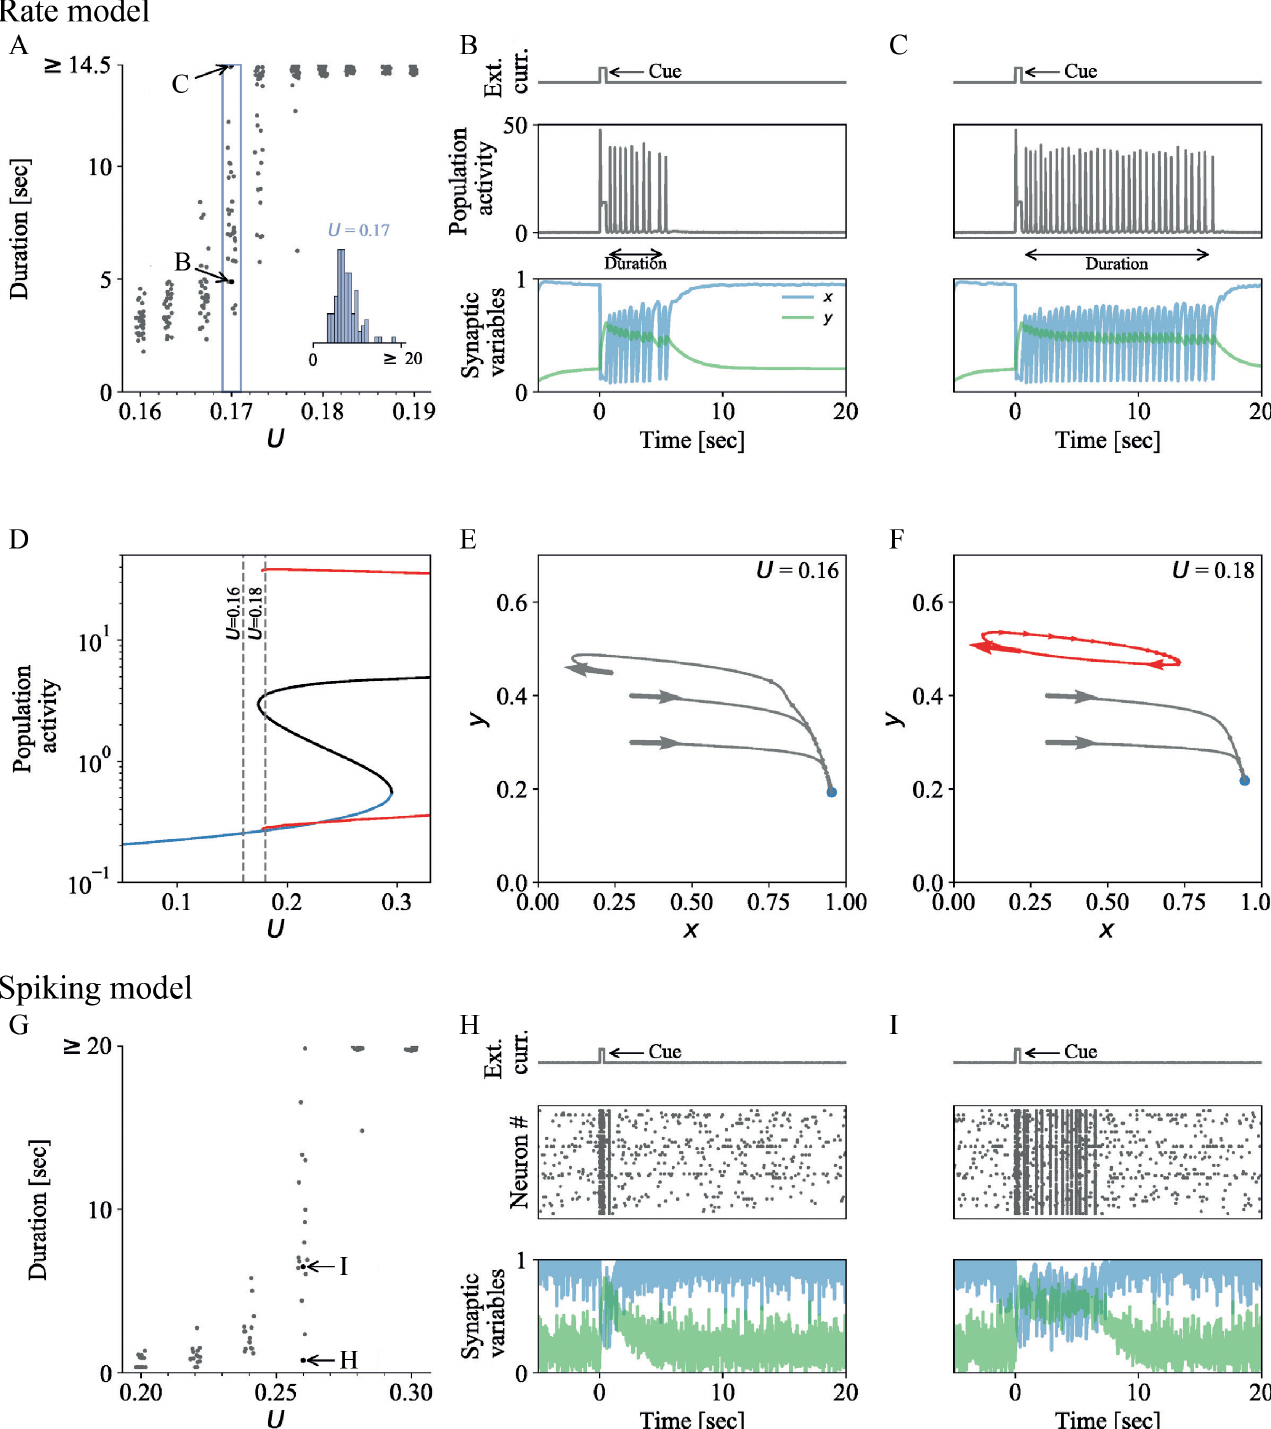
Fig 4. Transient WM activity is modulated by synaptic dynamics in STP rate and spiking networks without LPA signaling ( Δ U = 0). A-F Analysis of the STP rate model (see Models and methods, Table C in S1 Text; network parameters as in Table D in S1 Text except otherwise specified). A WM durations for 30 simulations at 10 values of U . As the phase transition is crossed, the range of durations of transient population activity upon cue stimulation increases b continuously (a hysteresis effect emerges if the cue is weak, see Fig I in S1 Text). Inset: Distribution of transient WM durations of 100 simulations at U b = 0.17. B-C Two simulations at U = 0.17. The external input current with the cue stimulus is shown in the top panel, population activity in the center and synaptic traces b